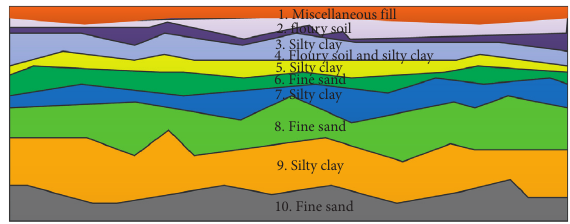
Figure 5: Geological sections.